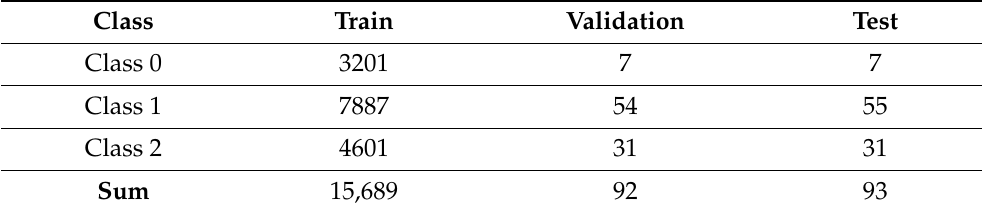
Table 10. Number of observations in the dataset and its distribution between